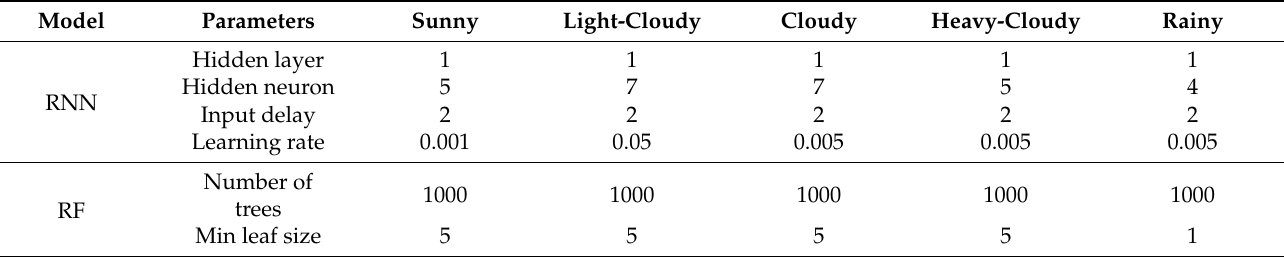
Table 5. Optimal hyperparameters of the ensemble